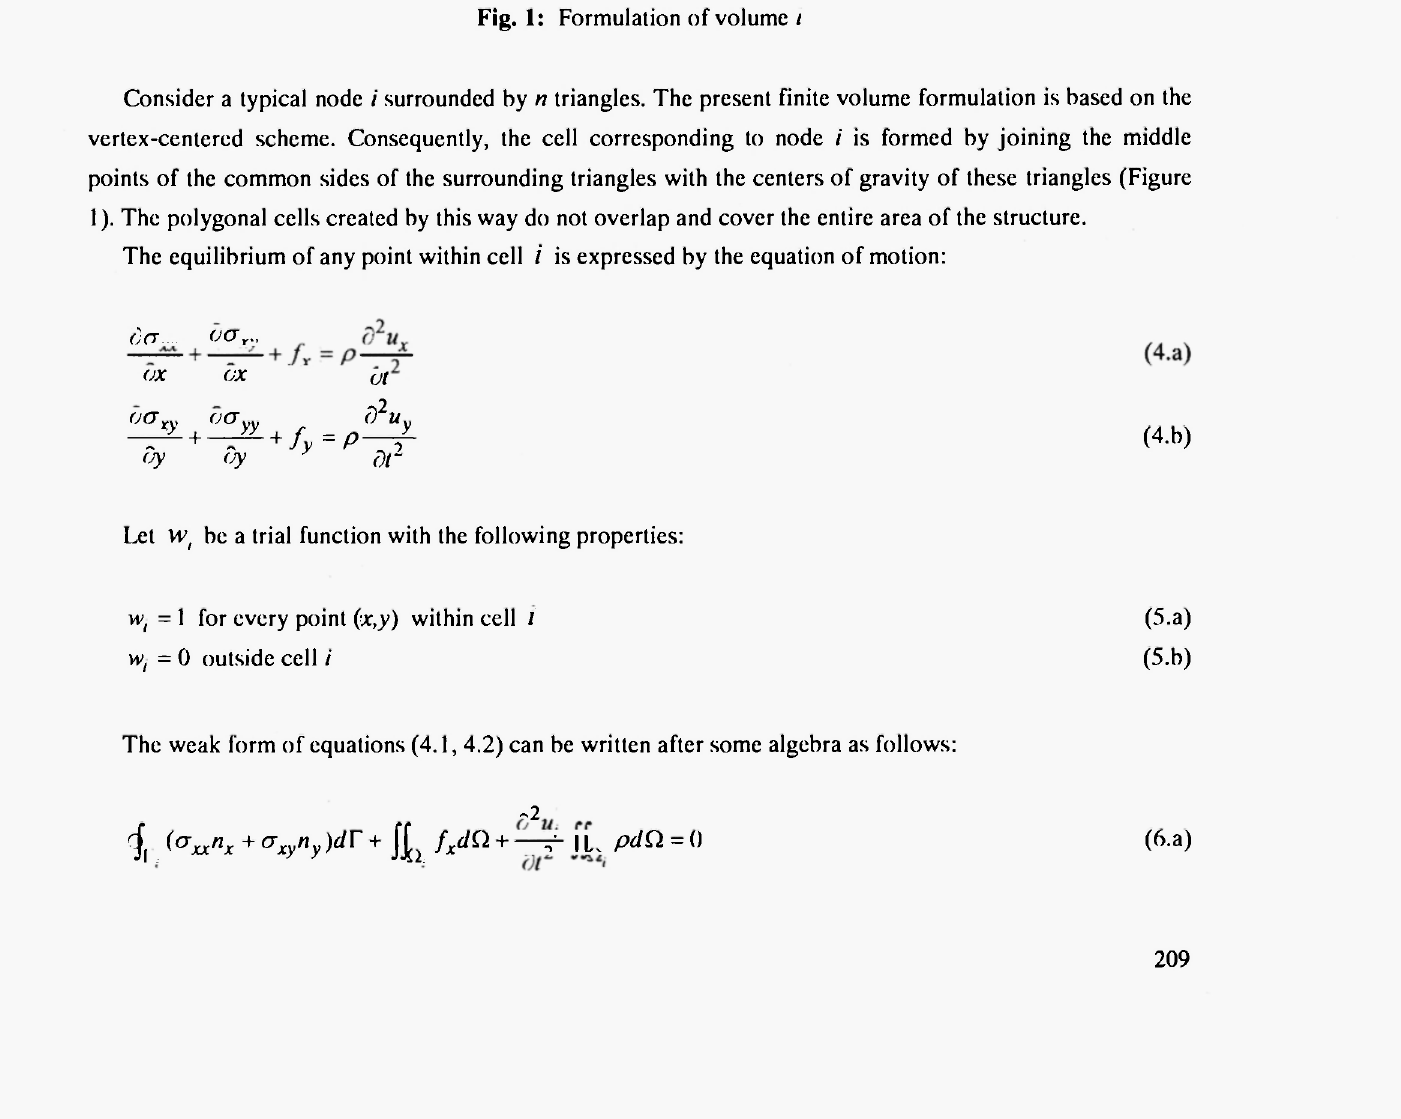
Fig. 1: Formulation of volume